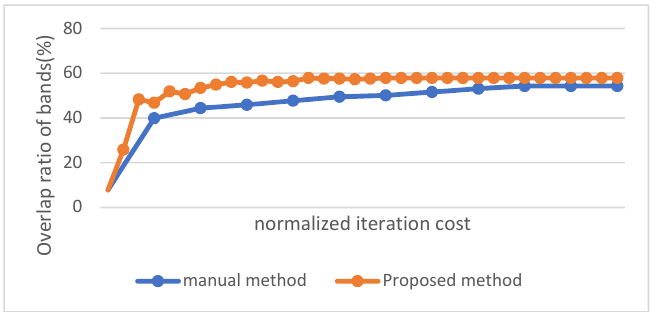
Figure 8. Optimization efficiency compared to a conventional flow on VCO.